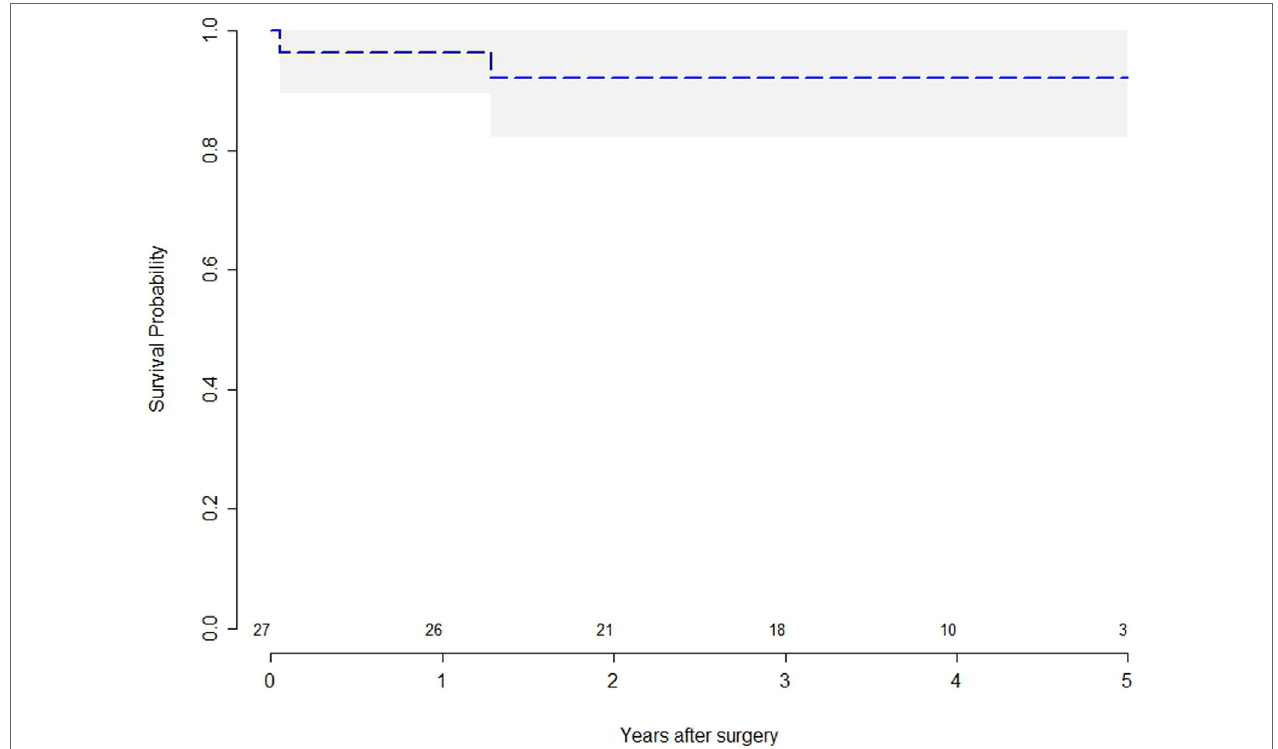
FigUre 2 | Kaplan–Meier survival curves for patients with tricuspid regurgitation after tricuspid valve repair